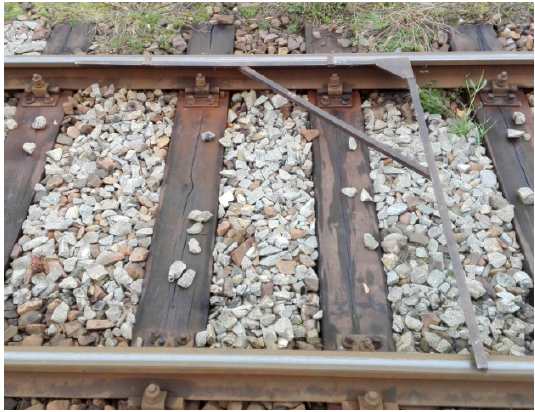
Figure 4. Track square (own photograph).